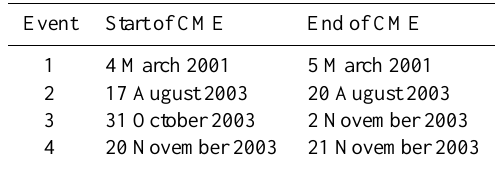
Table 1. Start and end of CME events used in this work. This clas- sification was carried out by Richardson and Cane (2004).